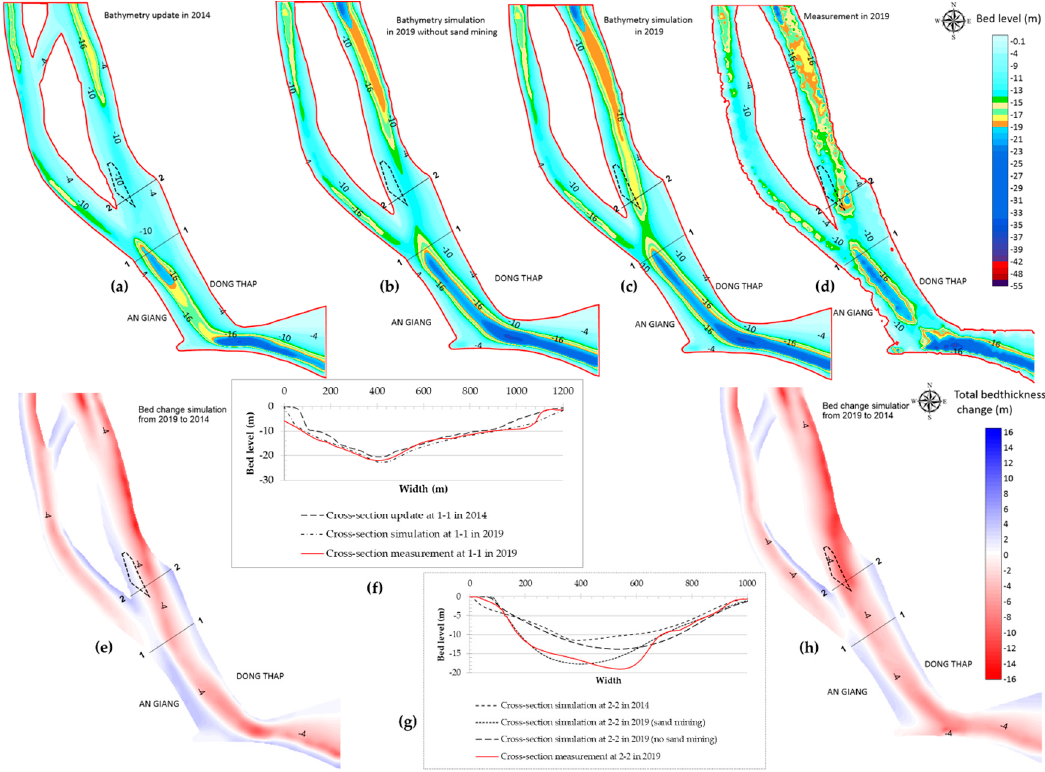
Figure 16. Simulation of the bed changes over 5 years from 2014 to 2019: ( a , c ) results of the simulations in 2014 and 2019, respectively; ( b ) the case of no sand simulations in 2019; ( d ) riverbed measurements in 2019; ( e , h ) bed change simulations during the period with no sand mining and sand mining, respectively; ( f , g ) comparison graphs of simulations and measurements at cross-sections 1.1 and 2.2, respectively.